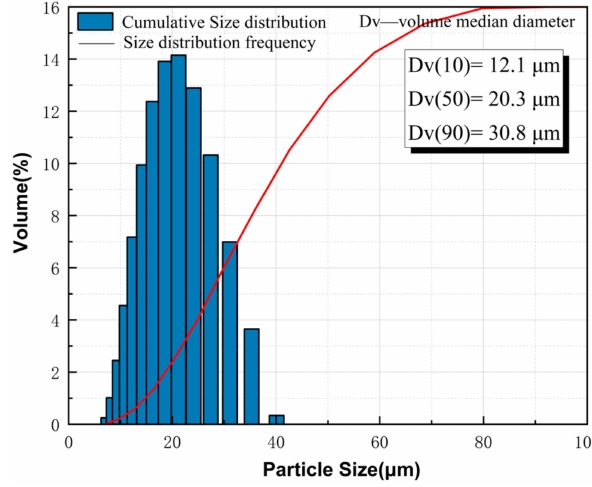
Figure 1. Particle size distribution of waste Al alloy